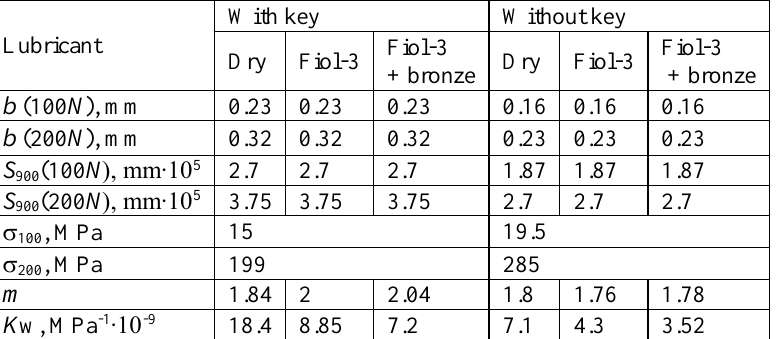
Results of studies of cylinders wear with